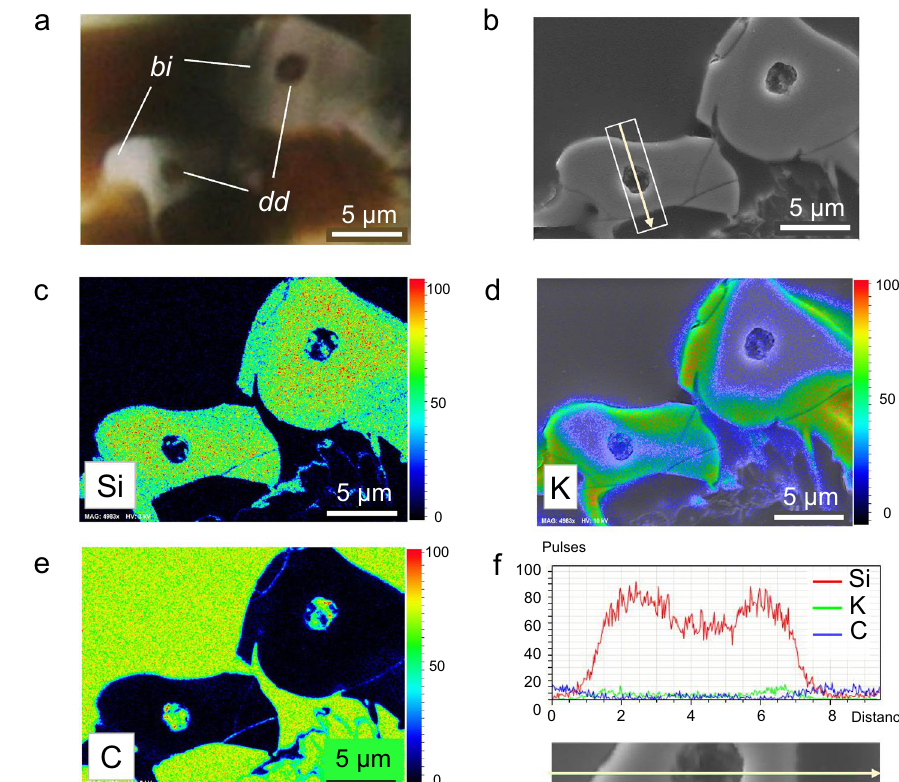
Fig. 9 Structure and composi- tion of the bilobate short cells of Guadua bamboo (San Carlos 10). a Light microscope